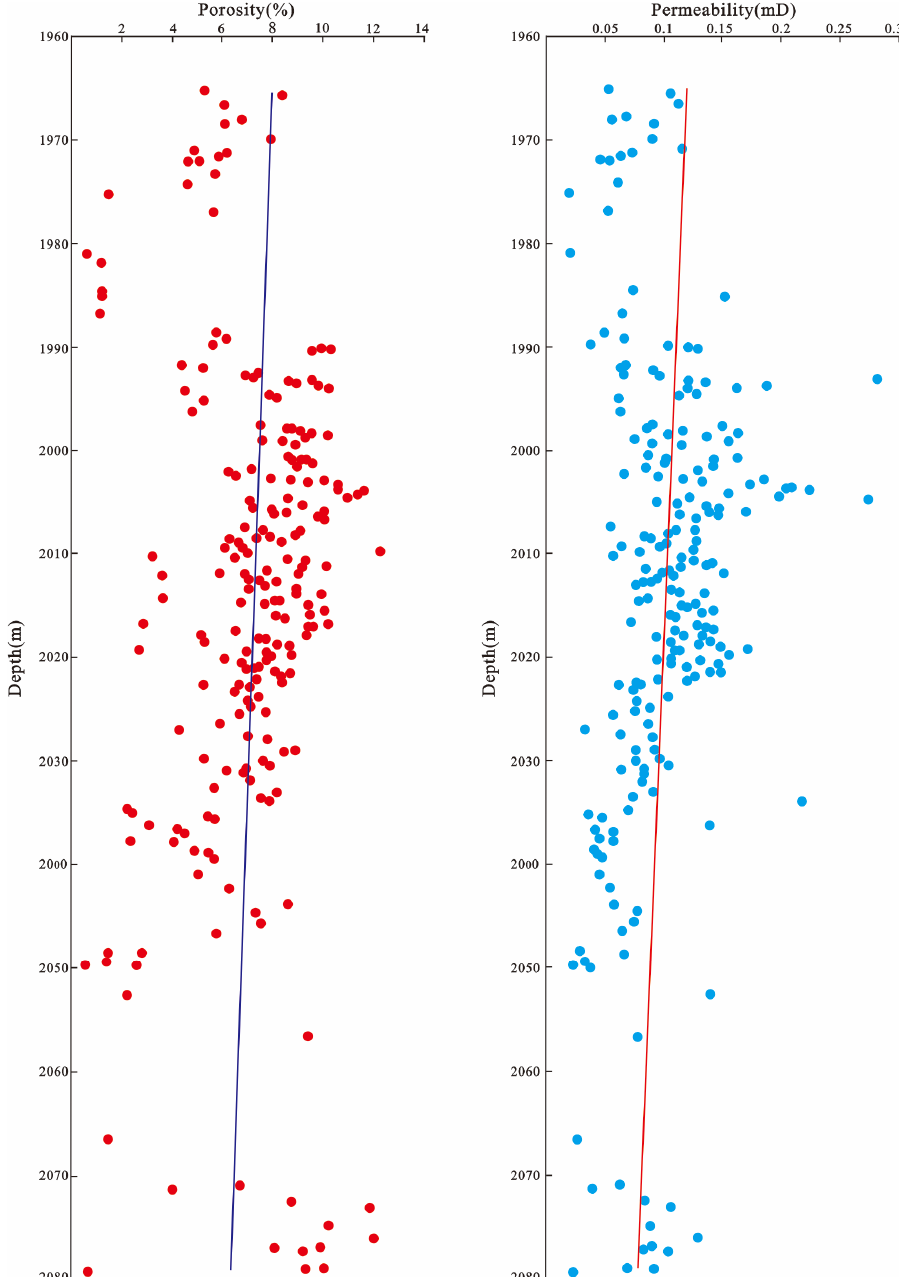
Figure 10. Relationship between depth and physical properties of well C96 in the Chang-7 Member.